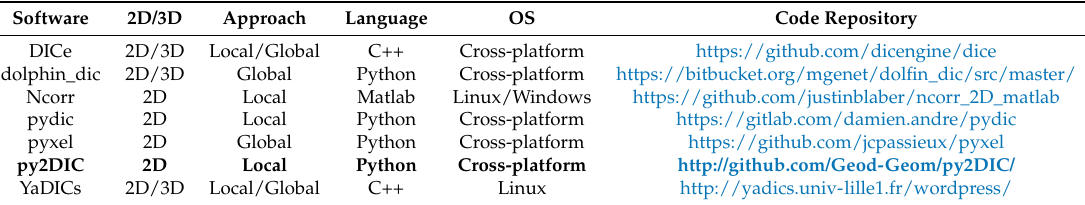
Table 1. Open-source Digital Image Correlation (DIC) software features.